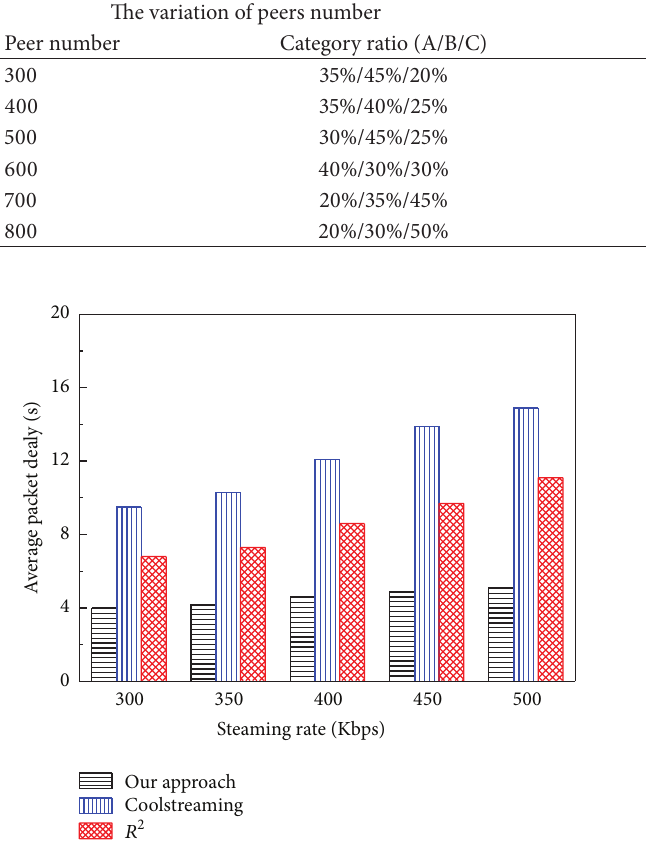
Figure 6: Average packet delay versus streaming rate.